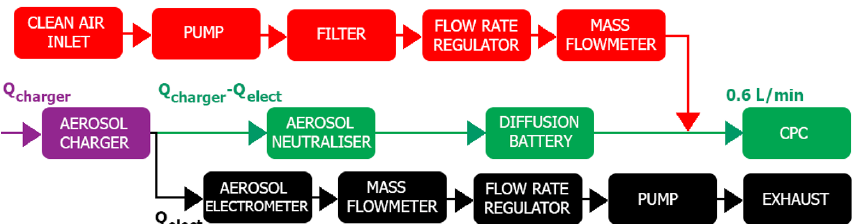
Figure A1. Setup to obtain the AP charging relationship. The red dashed rectangle is the part added to study the AP penetration through the